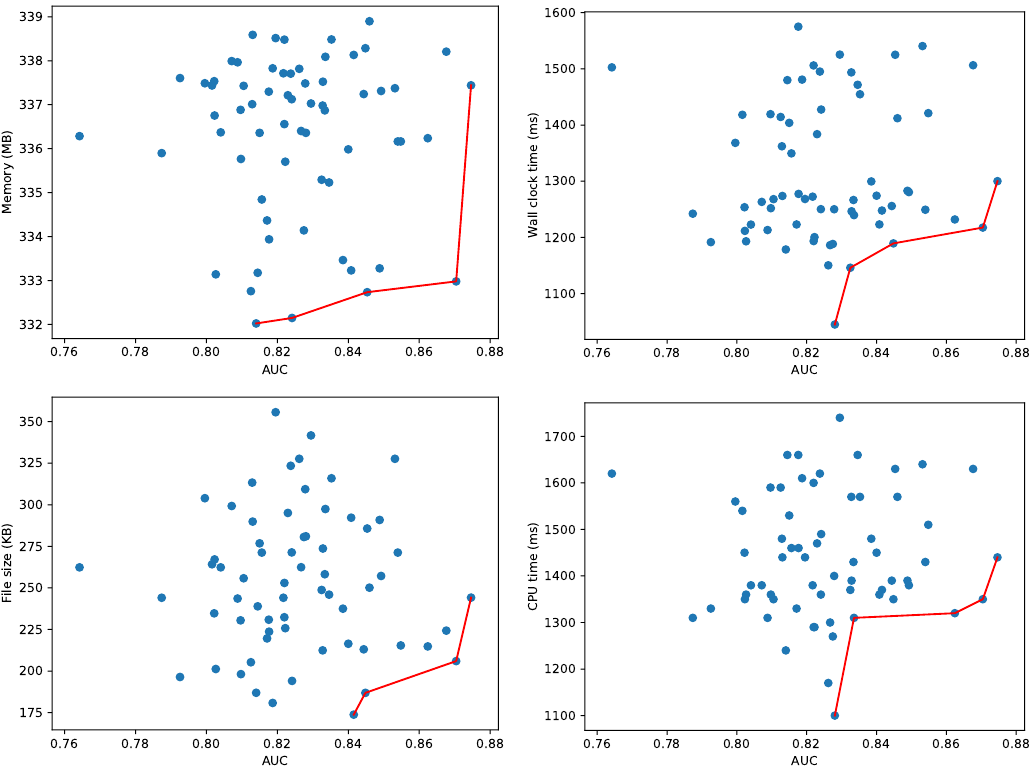
Figure 12. Pareto fronts for memory ( top left ), wall clock time ( top right ), file size ( bottom left ) and CPU time ( bottom right ) for the CICIDS 2017 dataset using 64 configurations of